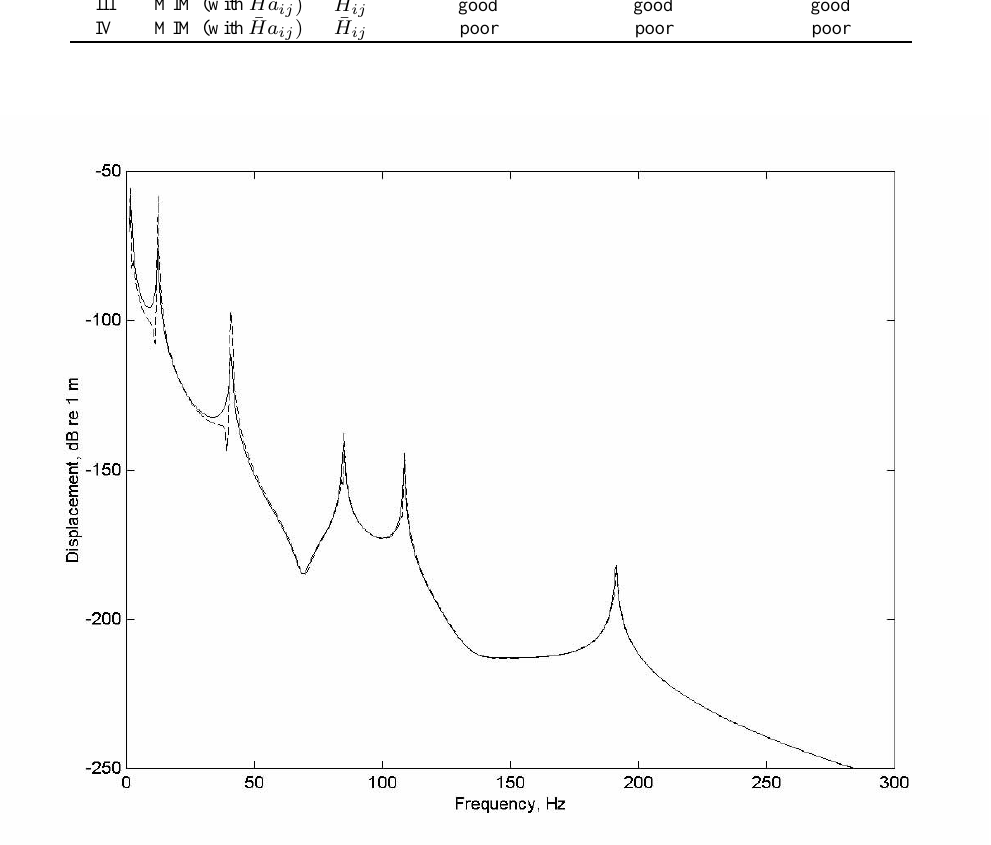
Fig. 2. Results using the Complex Stiffness Method. ––– Case I (with M 1 ); —— Case II (without M 1 ) ≡